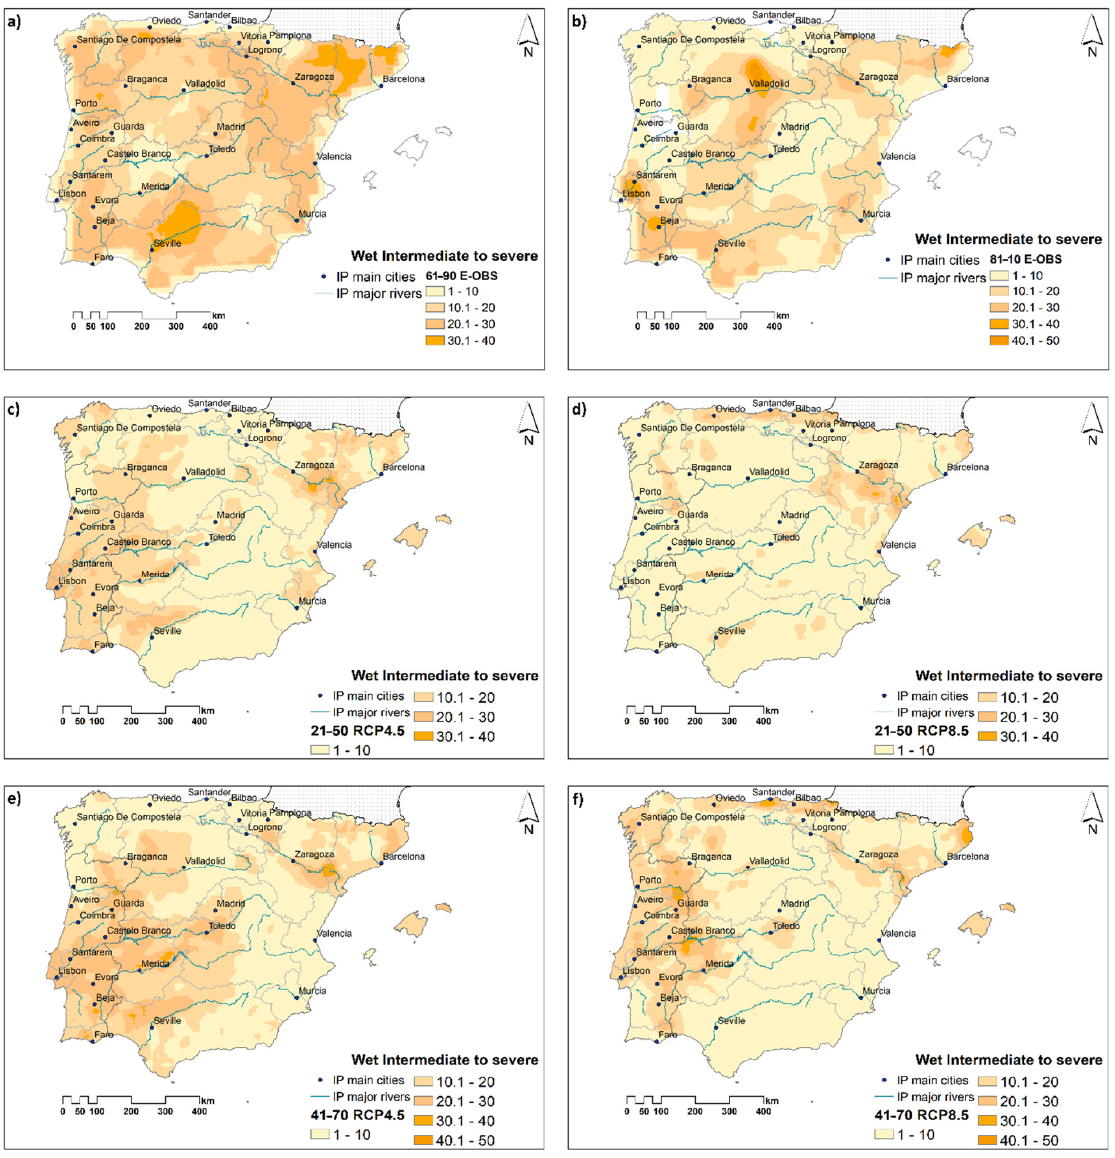
Figure 4. Duration in months of 12m-WASP intermediate-to-severe wet events in IP for the periods ( a ) 1961–1990; ( b )